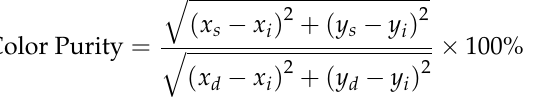
where ( x s , y s ) are the coordinates of a sample point; in our experiment all of the sample coordinates are basically the same, and the value is (0.152, 0.060), ( x d , y d ) are the coordinates of the dominant wavelength, in our experiment dominant wavelength at 442 nm, its coordinate is (0.1756, 0.0053) and ( x i , y i ) are the coordinates of the CIE coordinates of